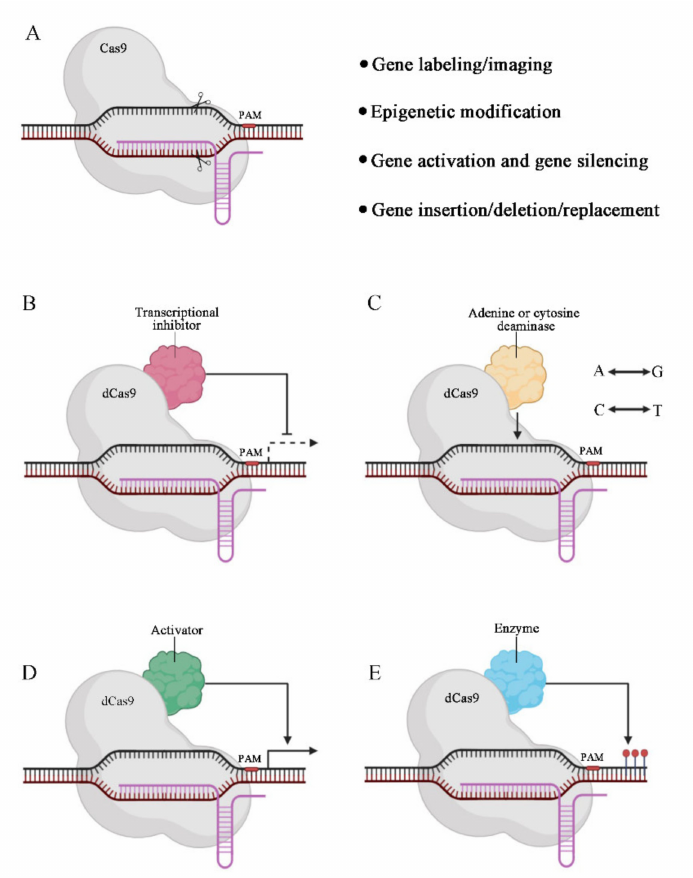
Figure 1. Applications of CRISPR/Cas9 system. ( A ) Schematic illustration of the molecular mech- anism of CRISPR/Cas9 system. ( B ) The dCas9 fused to a transcriptional inhibitor (red shape) can repress transcription. ( C ) A DNA base editor consists of a dCas9 and an adenine or cytosine deam- inase (yellow) that converts A to G or T to C, respectively. ( D ) The dCas9 fused to transcriptional activator (green) can boost transcription. ( E ) The dCas9 fused with enzymes (blue) that can modify epigenetic marks of DNA can be used to change gene expression status (Created with BioRender.com, accessed on 5 September